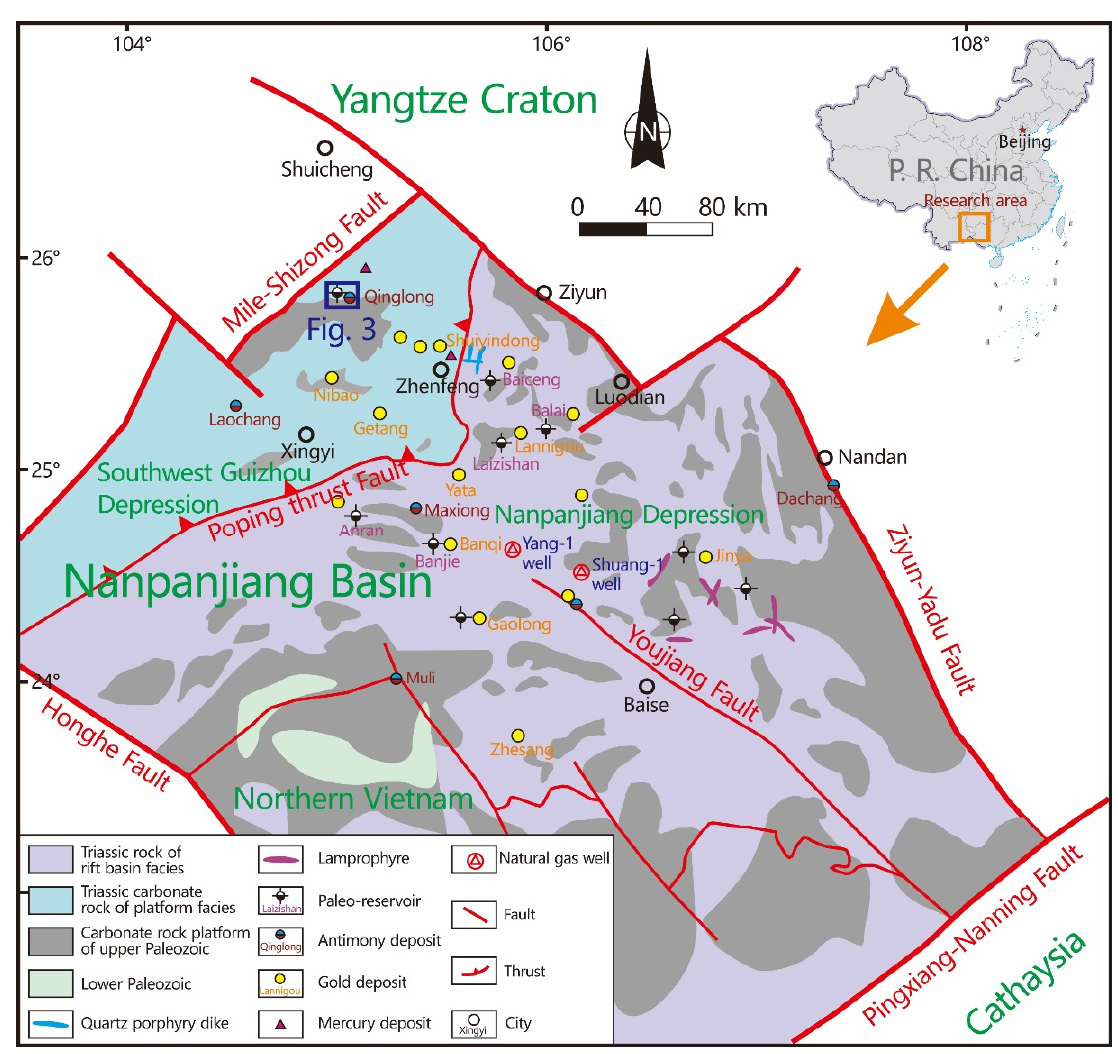
Figure 1. Simplified geologic map showing the distribution of tectonic units and Au-Sb deposits in the Nanpanjiang basin, SW China (modified after [ 38 ]).